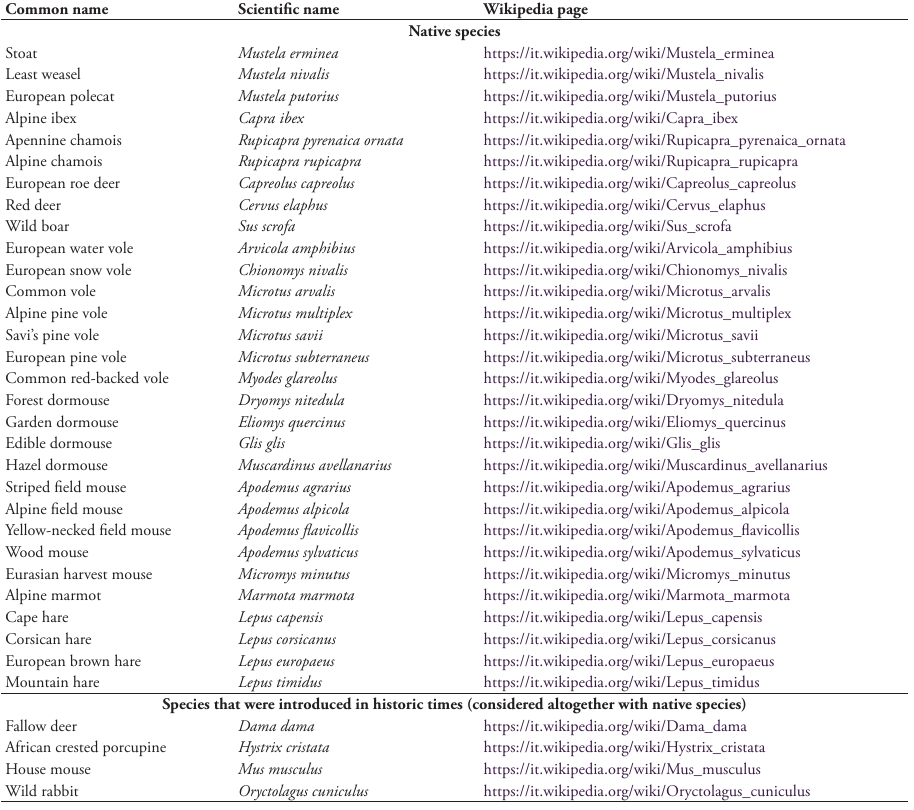
Among the IAS, we also disregarded the brown rat ( Rattus norvegicus ) and the black rat ( Rattus rattus ), as they are mostly managed by rodent control companies and their search volumes could be ascribable to infestation levels in urban areas. We also excluded the red squirrel ( Sciurus vulgaris ) from the list of native species, as its news coverage was related to the management of S. carolinensis (Bertolino et al. 2014; Lioy et al. 2019) and two large carnivores, the grey wolf ( Canis lupus ) and the brown bear ( Urus arctos ), whose news coverage was complex and volatile, due to their interaction with humans and the politi- cal debate around their management. We also excluded marine mammals, as they could have stronger seasonal patterns than other mammal species, due to summer tourism and mortality events. Time series were downloaded from 29 June 2015 to 3 February 2020. We adopted Bayesian structural time series (BSTS, Brodersen et al. 2015) to com- pare differences in time-series after the Union list. BSTS can estimate the causal effect of an intervention over a single target time-series, by comparing its post-treatment values with a counterfactual constructed from a synthetic control, constituted by un- treated time series that were predictive of the target time series in the pre-treatment period. The post-treatment difference between the target time-series and the counter- factual represents the causal effect of the